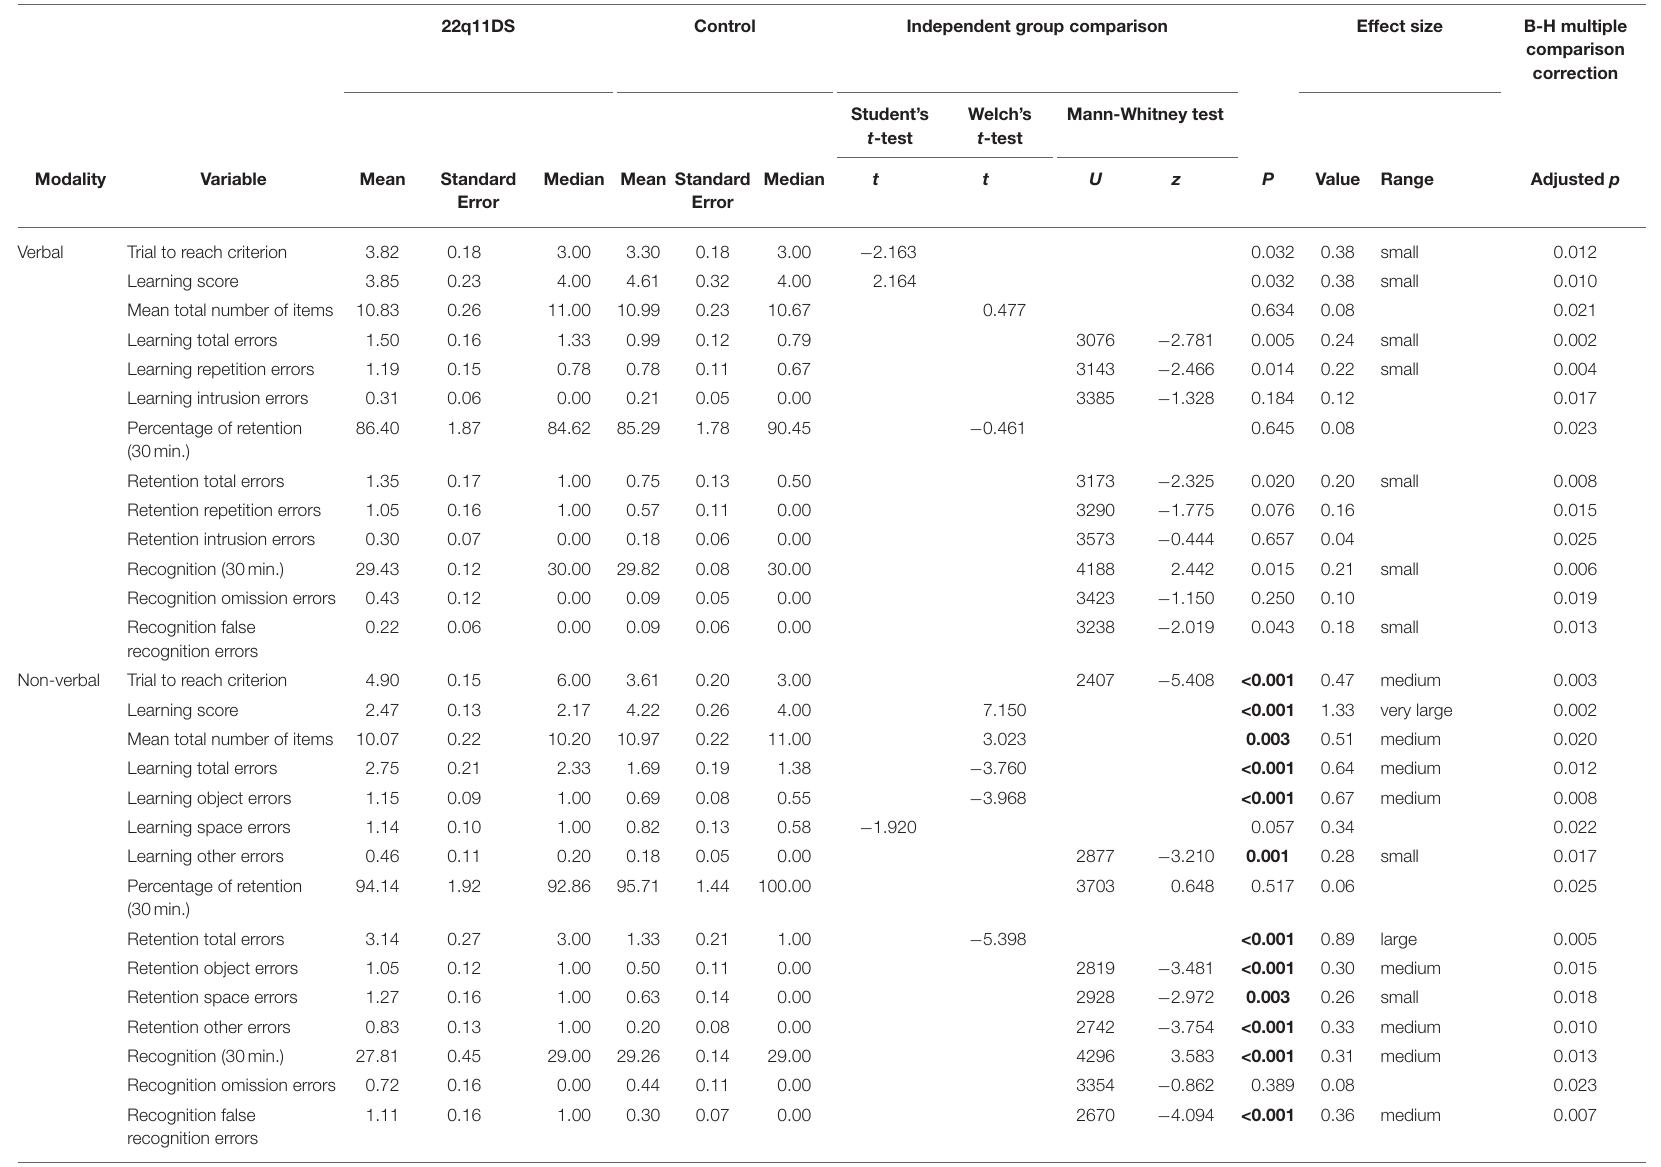
TABLE 2 | Descriptive characteristics and between group comparisons of learning and memory